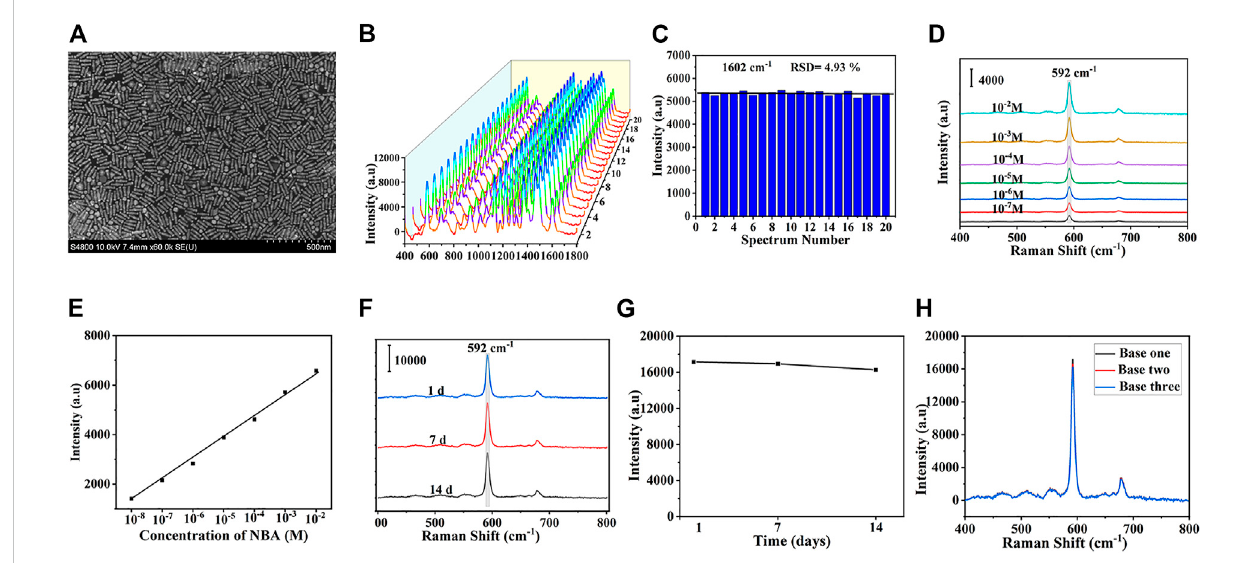
FIGURE 3 (A) SEM images of DS Au nanorod array. (B) SERS spectra at 20 randomly selected spots and (C) the corresponding signal intensity histogram at 1,062 cm − 1 . (D) SERS spectra of DS Au nanorod array at different concentrations of NBA (10 − 2 -10 − 8 mol/L). (E) Relationship between SERS intensity and logarithm of NBA concentration at 592 cm − 1 . (F) The average SERS spectra of the NBA-labeled SERS substrate after the storage of 1 day, 7 days, 14 days and (G) the corresponding SERS intensities of the bands at 592 cm − 1 . (H) SERS spectra of three NBA-labeled DS Au nanorod array synthesized at different batches.